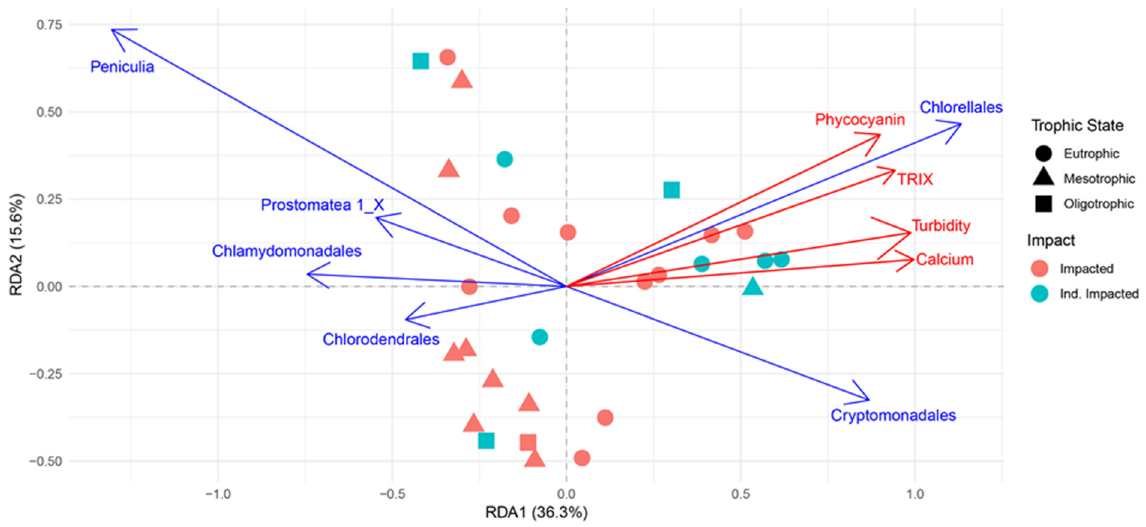
Figure 5. Non-metric Multidimensional Scaling ordination, within two dimensions of protists com- munities within sampling sites, during 5–10 October 2019, along the New River, Belize. Legend shows trophic state and impact status. Ellipses represent the location of group centroids to at a 0.95 confidence level. Stress level: 0.07.